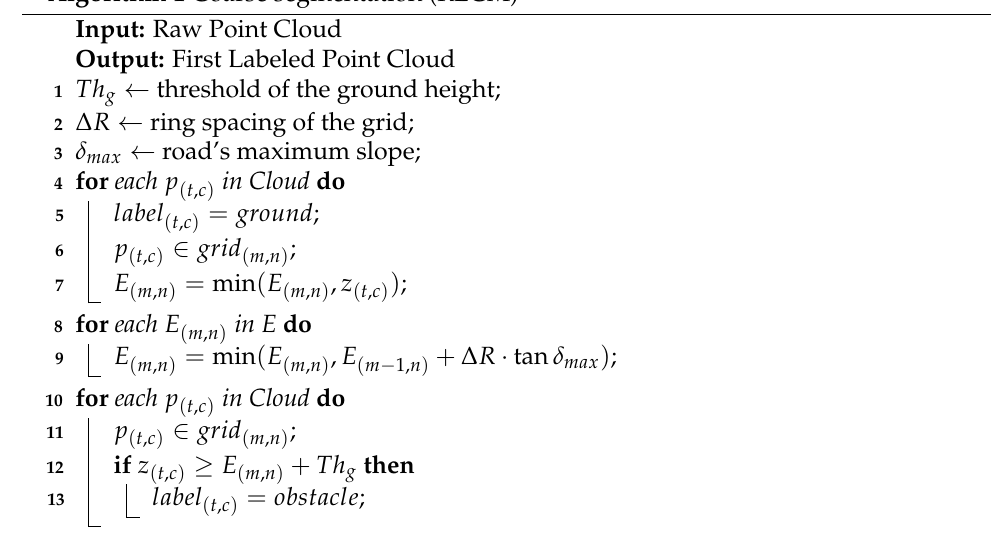
Algorithm 1 Coarse segmentation (RECM)